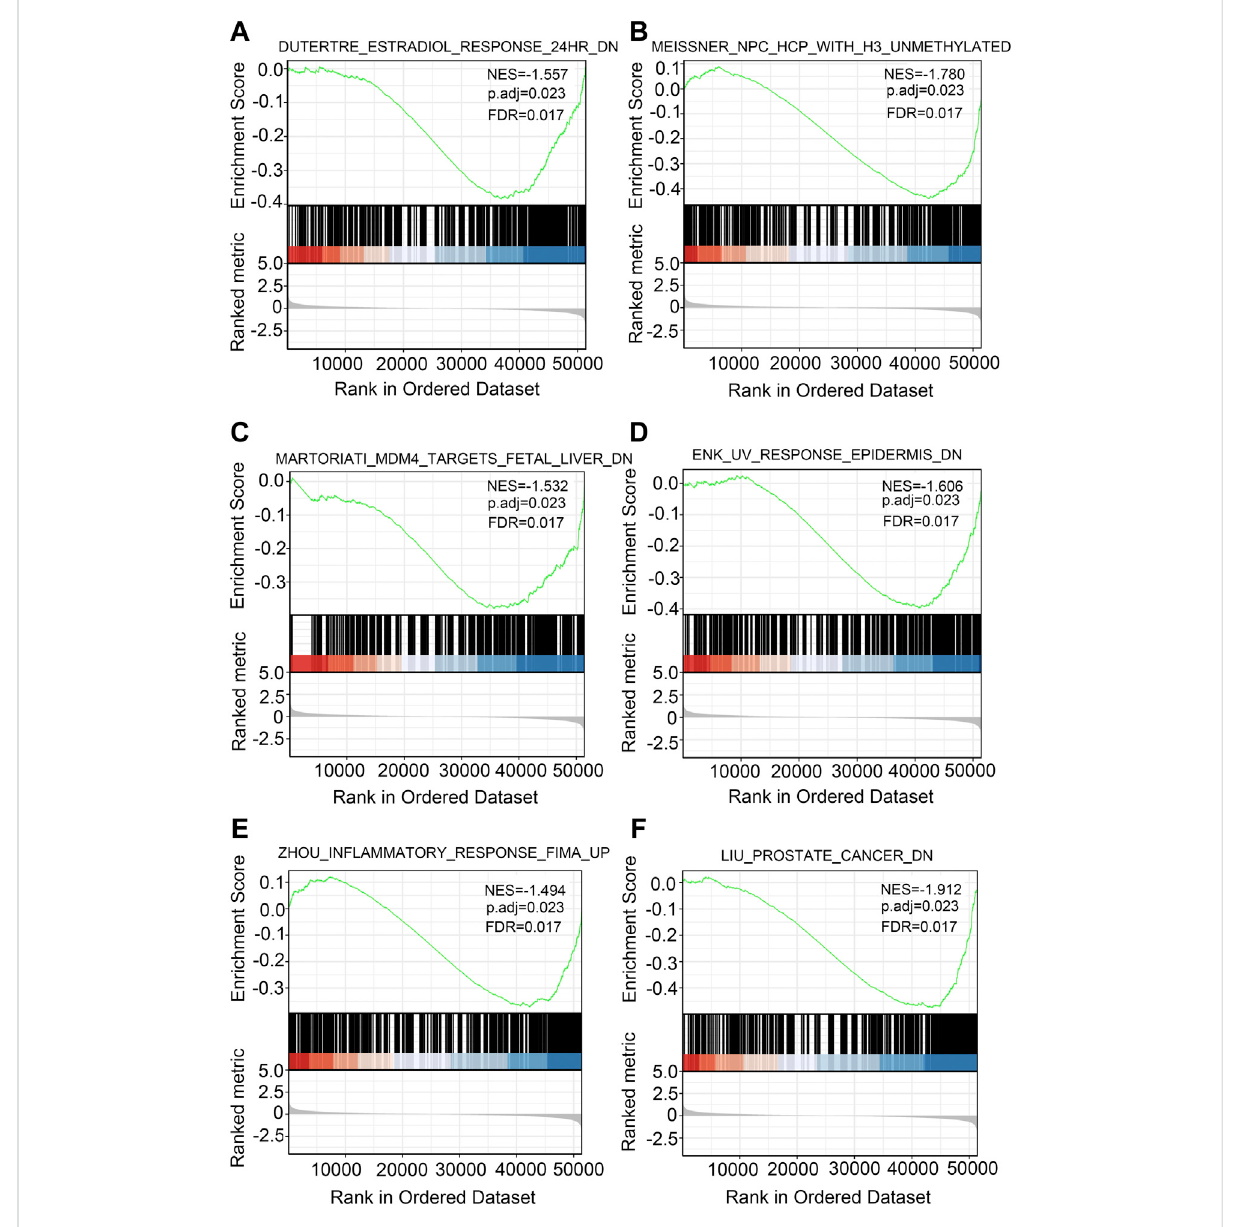
FIGURE 9 GSEA in OSCC. Several pathways were differentially enriched in OSCC patients according to high and low DDX59-AS1